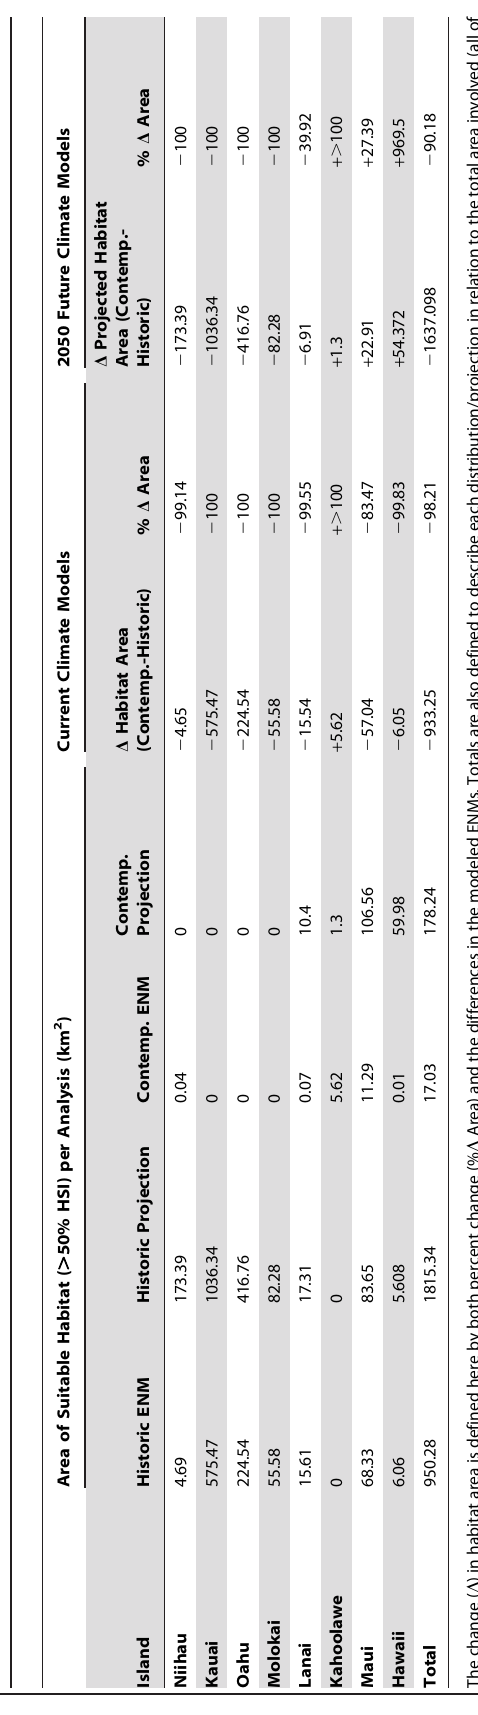
Table S1 A–D: The results of the Principal Component Analysis (PCA) of precipitation and temperature vari- ables (i.e. Bioclim 12–19 and 1–11, respectively) for both contemporary (A & C) and future (B & D)